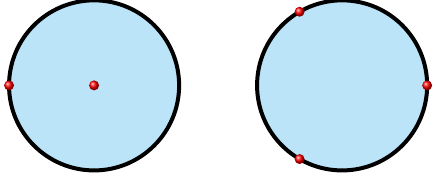
Figure 10 . The smallest possible stable components that appear when contracting